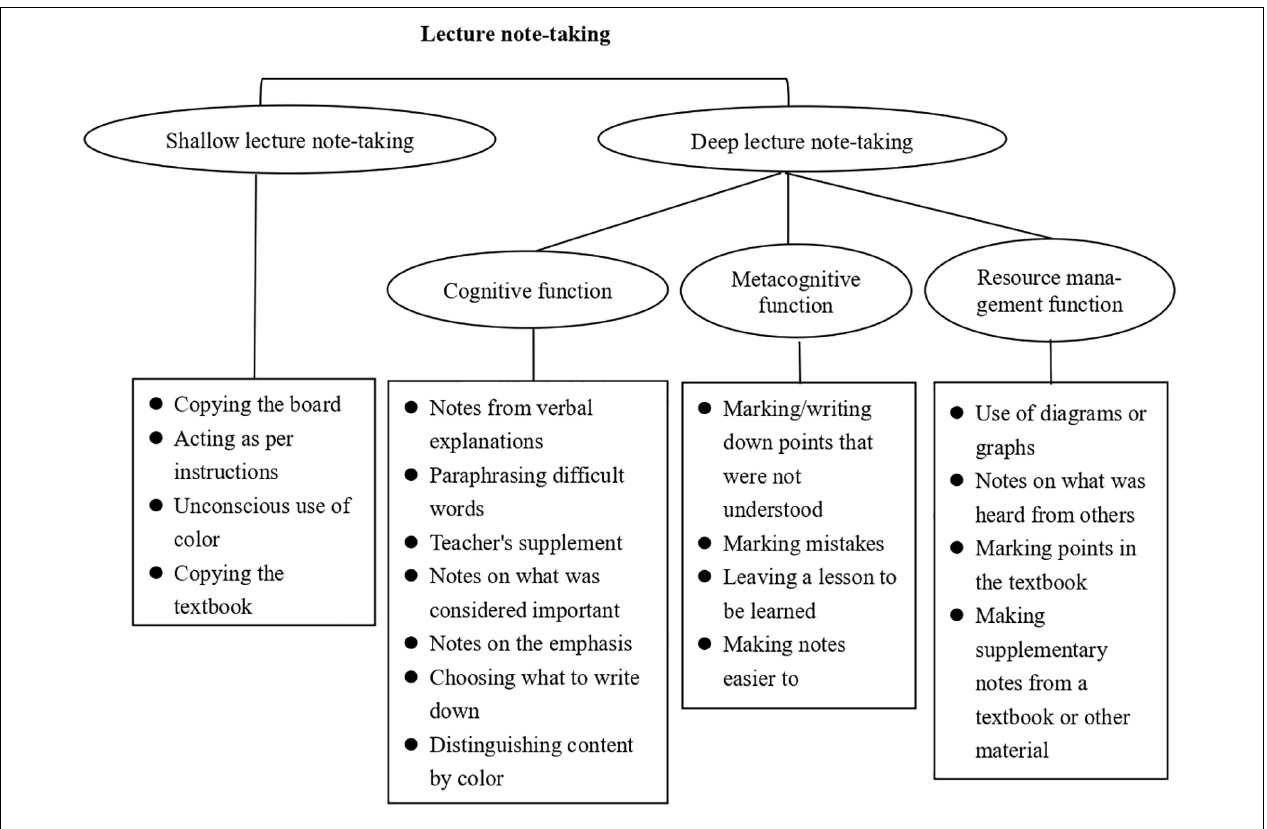
FIGURE 3 | A new framework for lecture